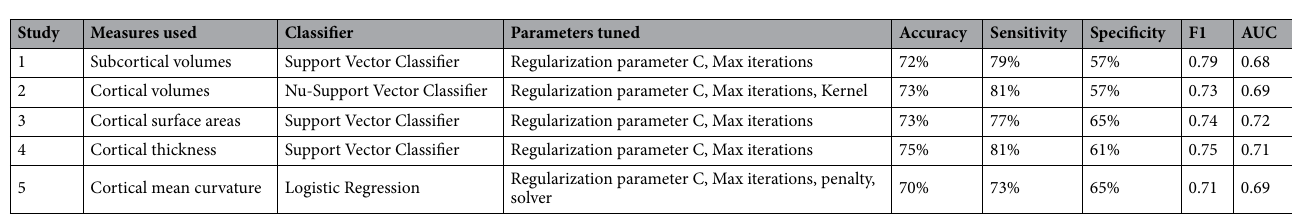
Table 2. Classification performance using independent